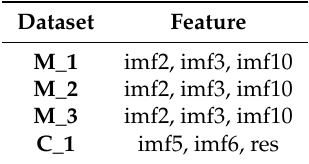
Figure 8. C_1 load series decomposition results. Table 2. Feature selection